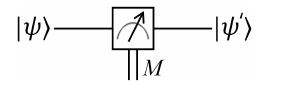
Figure 2. Single qubit measurement